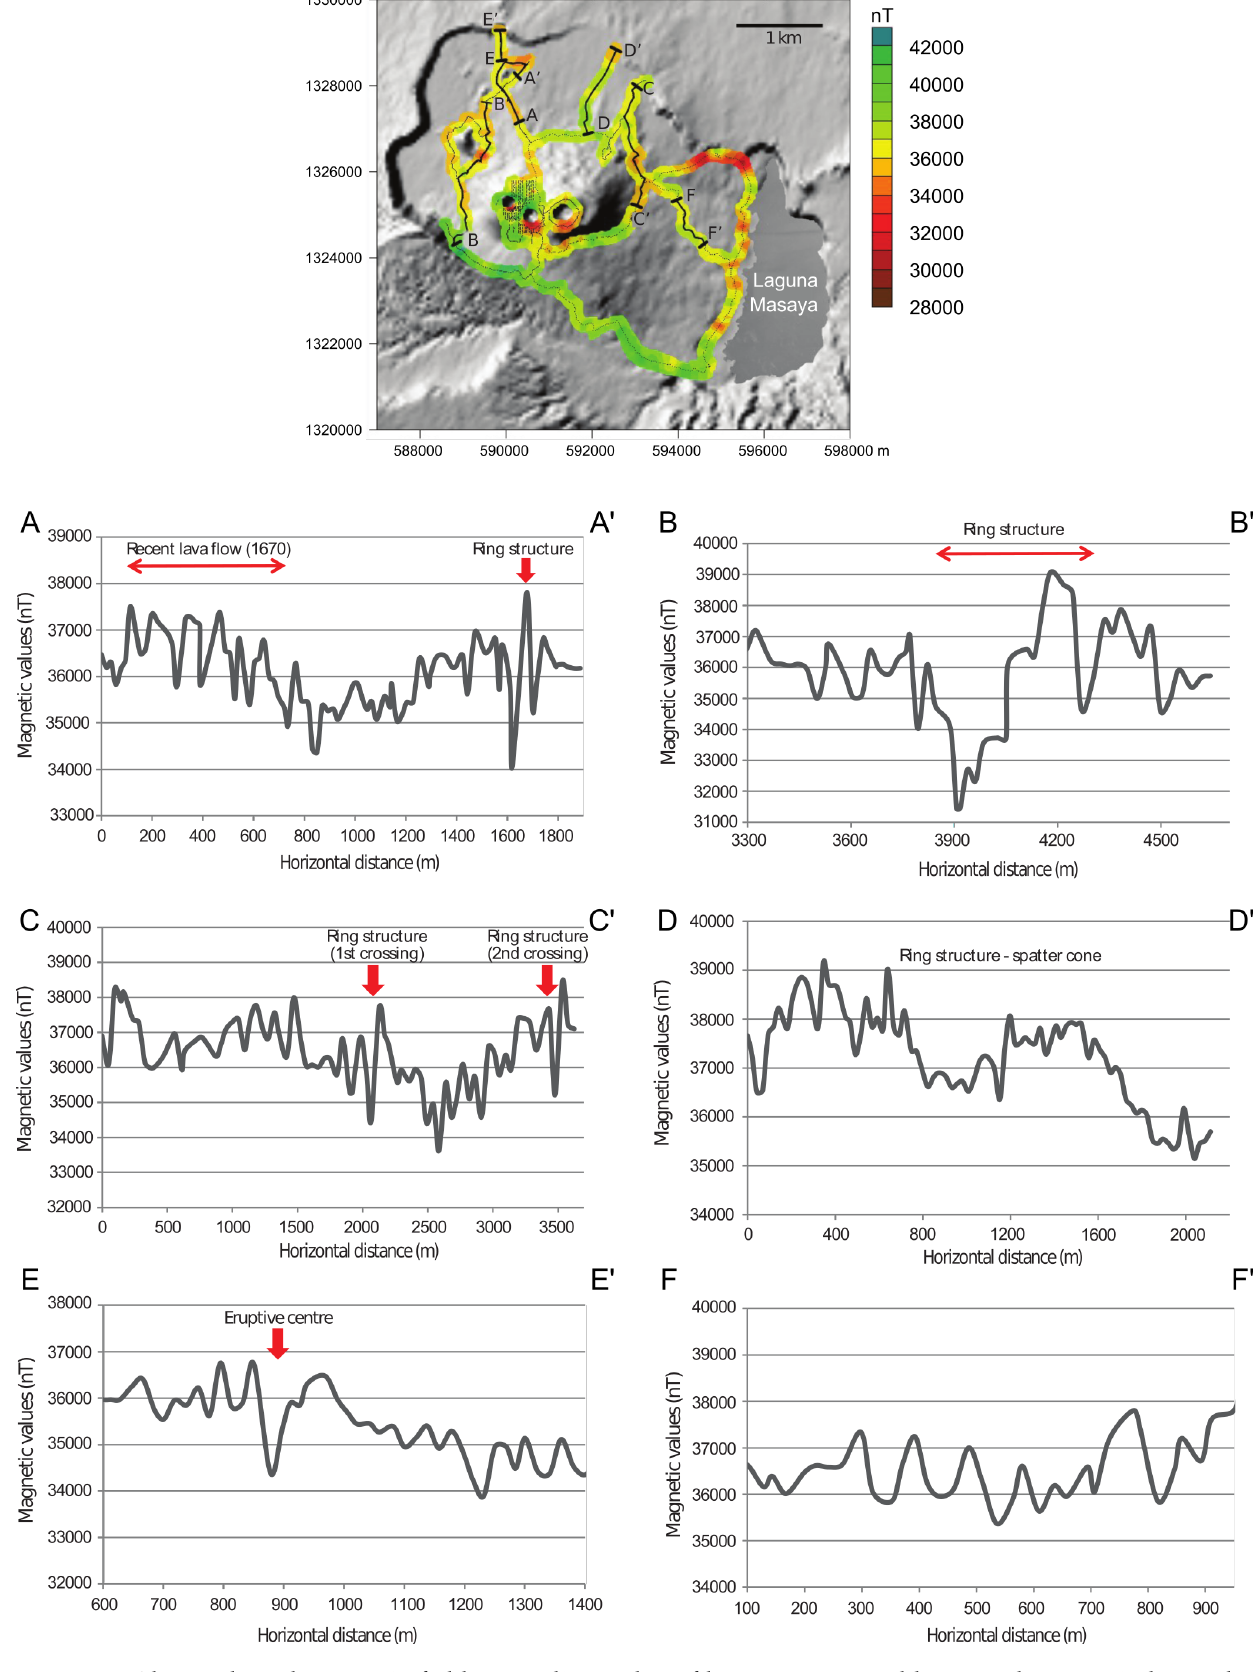
Figure 6: Observed total magnetic field anomalies and profiles on Masaya caldera. Red arrows indicate the proposed location of the ring fracture. While [A] to [E] profiles cross the suggested ring structure, profile [F] shows the normal background magnetic variation on the caldera floor (control